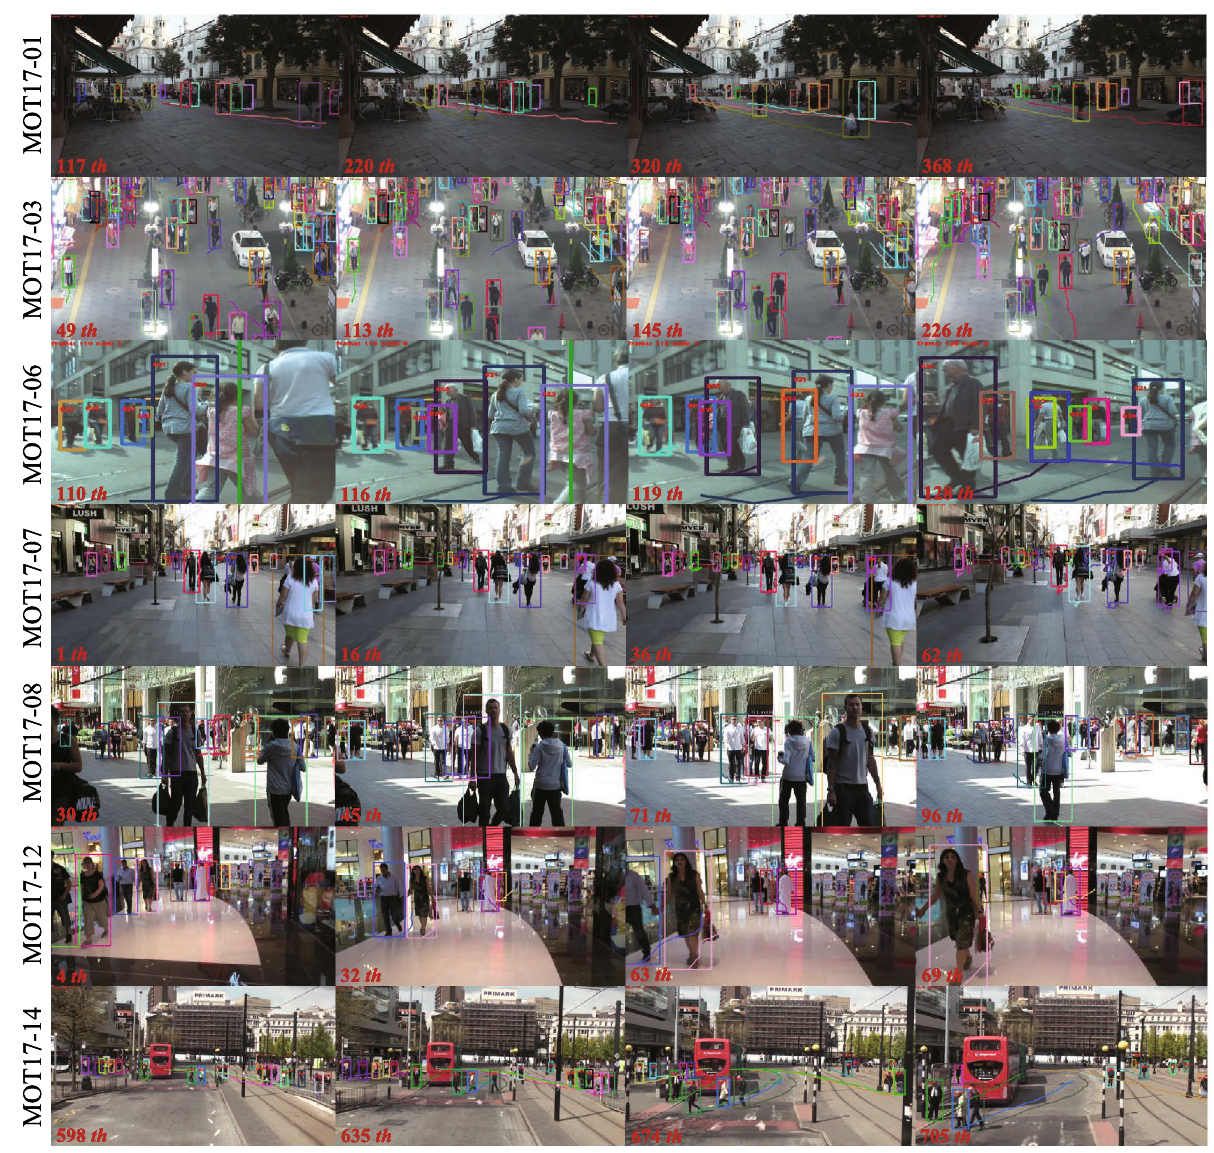
Figure 9. Visualization of tracking